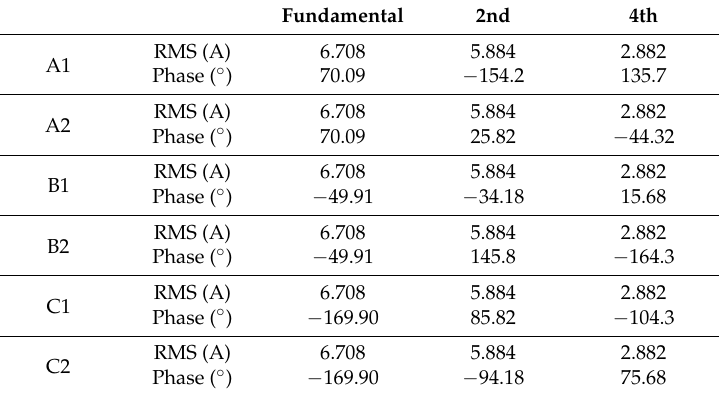
Table 4. Stator armature steady state current RMS and phase of fault